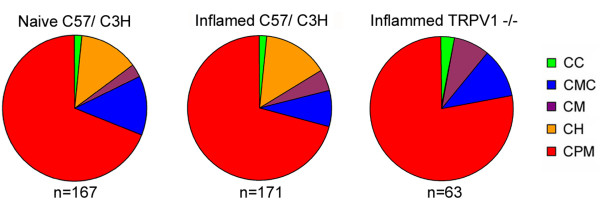
Distribution of C-fiber types is unchanged following inflammation. The prevalence of CH-fibers does not increase after inflammation compared to naïve mice. (p value < 0.17; χ2 test.) Neither naïve (not shown) nor inflamed TRPV1-/- animals have CH-fibers.